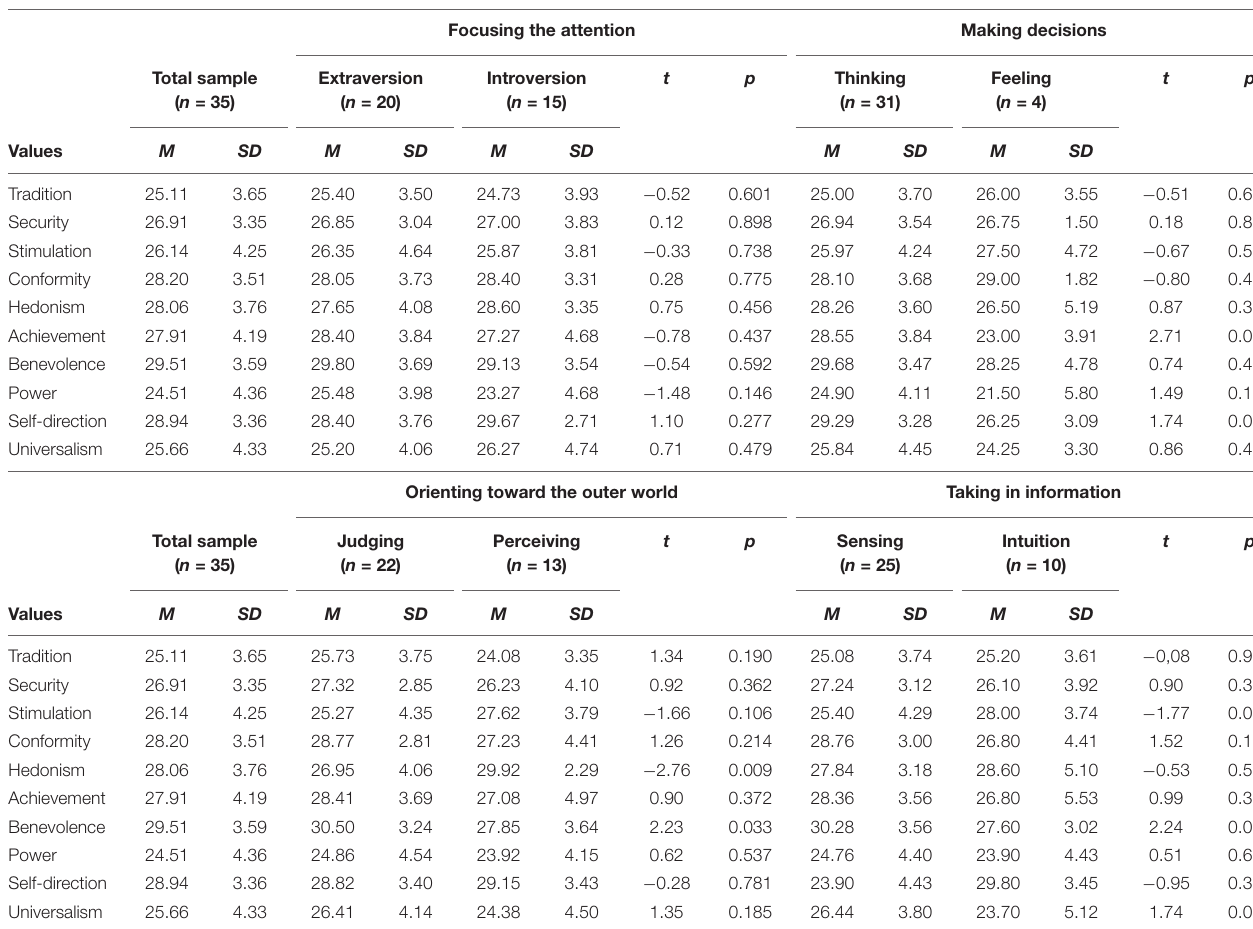
TABLE 6 | Types of values. Differences according to the main characteristics of the Psychological Types. Focusing the attention Making